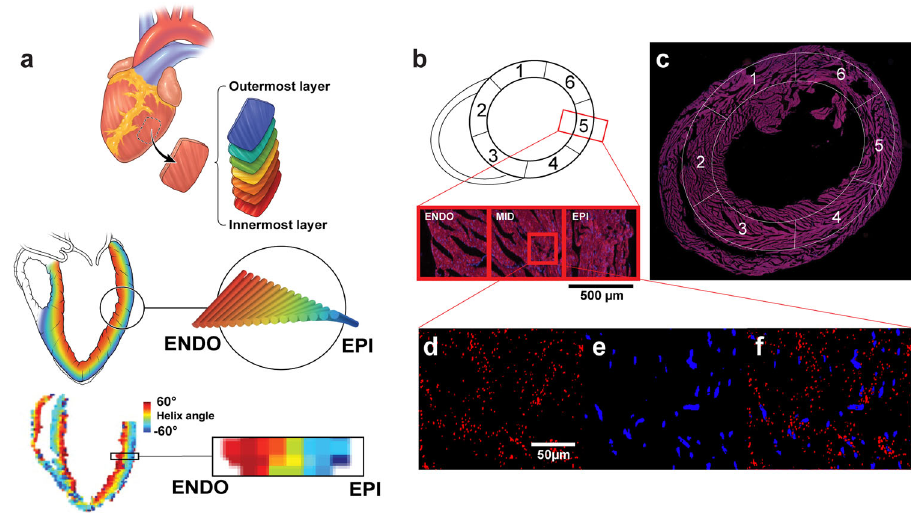
Fig. 3 Helix angle analysis and RNA-FISH imaging and quanti fi cation of exercise and sedentary mouse hearts. a Helix angles change from the endocardium to epicardium between sedentary and exercised mice. b A visual representation of the location of the six AHA sections and a zoomed in images of the complete cross-section across each transmural layer. c Complete image of sectioned mouse tissue with AHA sections overlayed. d CITED4 signal isolated within mid-myocardium. e DAPI signal isolated and magni fi ed in the mid-myocardium. f CITED4 and DAPI signal imaged from mid-myocardium overlayed.